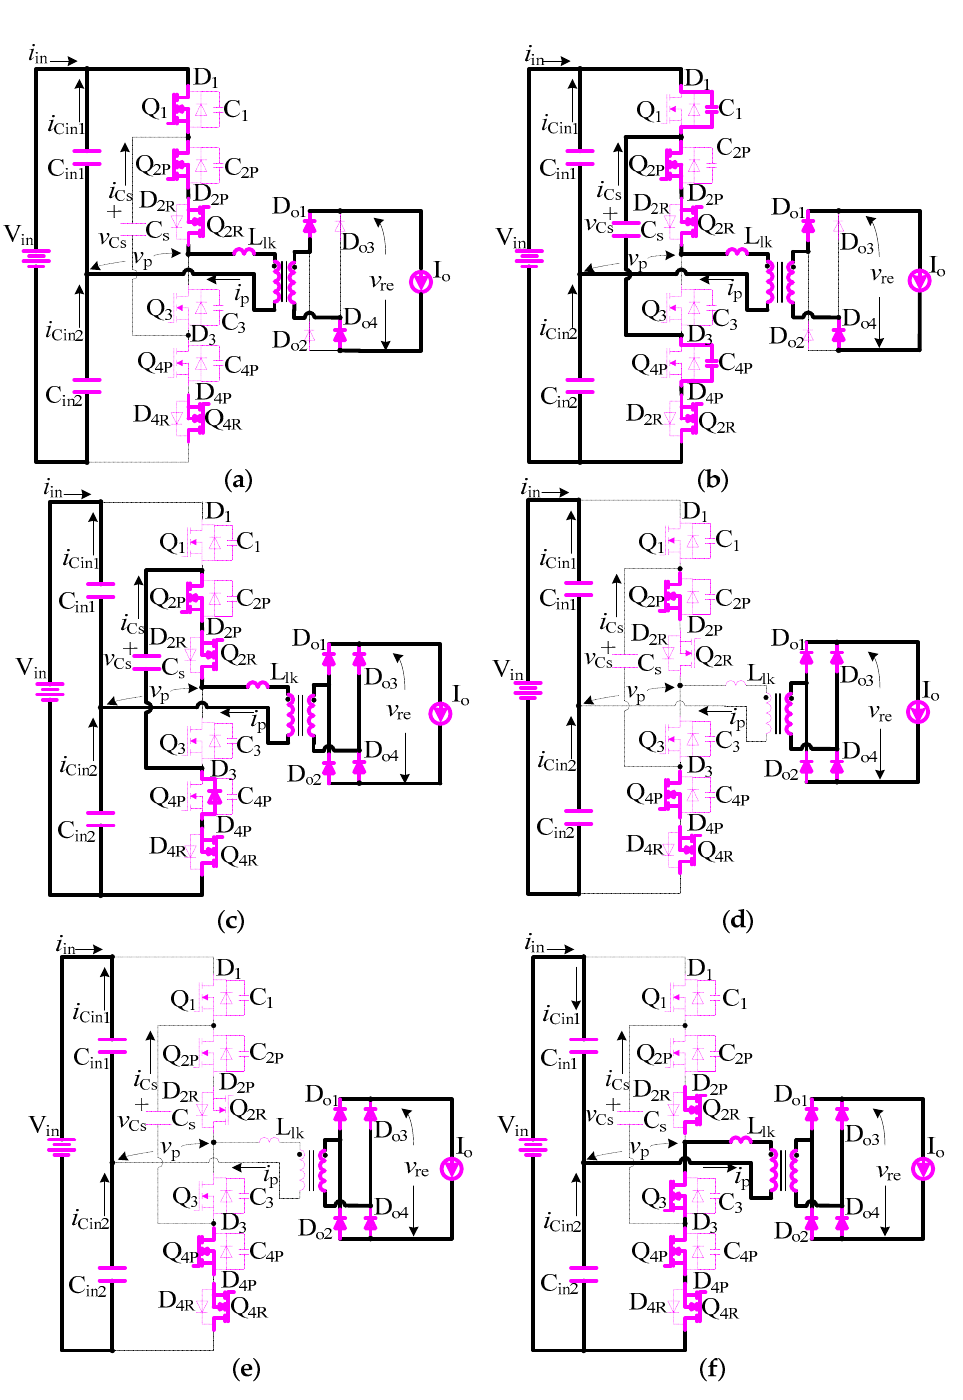
Figure 4. Identical circuits: ( a ) Mode 1; ( b ) Mode 2; ( c ) Mode 3; ( d ) Mode 4; ( e ) Mode 5; ( f ) Mode 6.